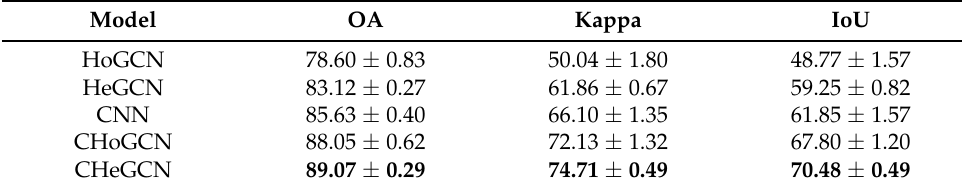
Table 5. The quantitative comparison of different models in ablation